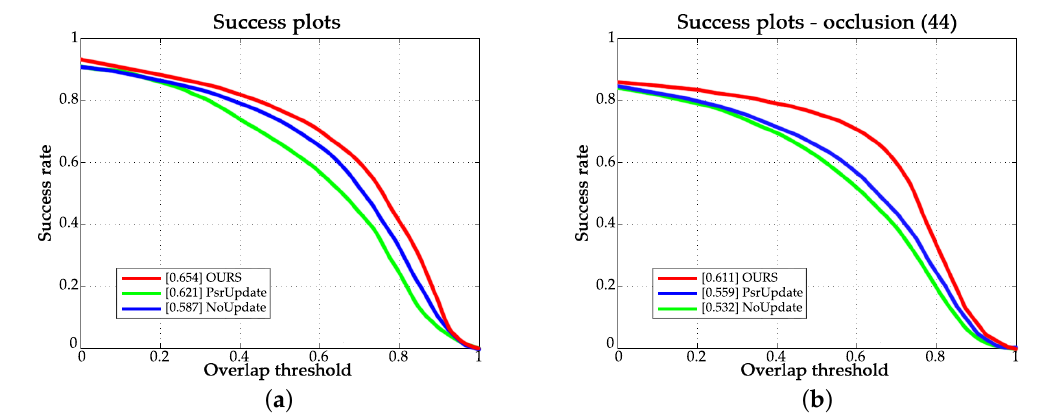
Figure 8. Tracking performance of different updating methods. ( a ) Success plots on OTB-2015; ( b ) Success plots over sequences with occlusion attribute.